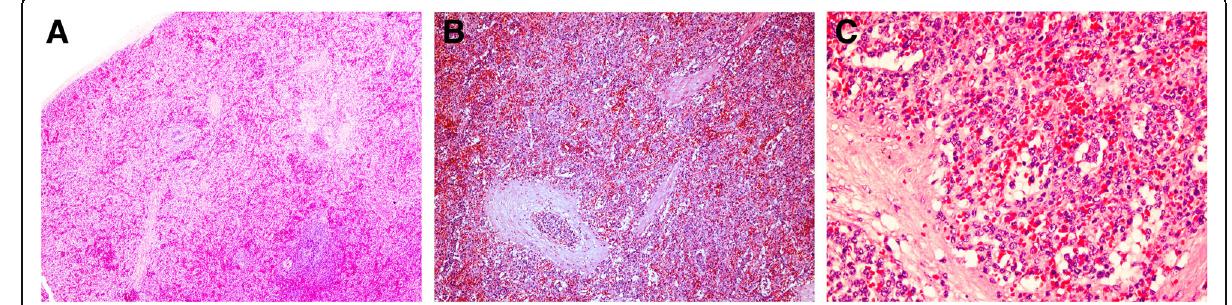
Fig. 2 Pathological features of spleen. a : HE staining, 4 × 10 magnification. Enlarged pulp sinuses were detected under the microscope. b : HE staining, 10 × 10 magnification. The spleen sinuses were filled with the lymphomatous cells. c : HE staining, 40 × 10 magnification. The lymphomatous cells were mainly medium-sized with round nuclei and multiple small nucleoli. Mitosis was easily detectable. White pulps were reduced and